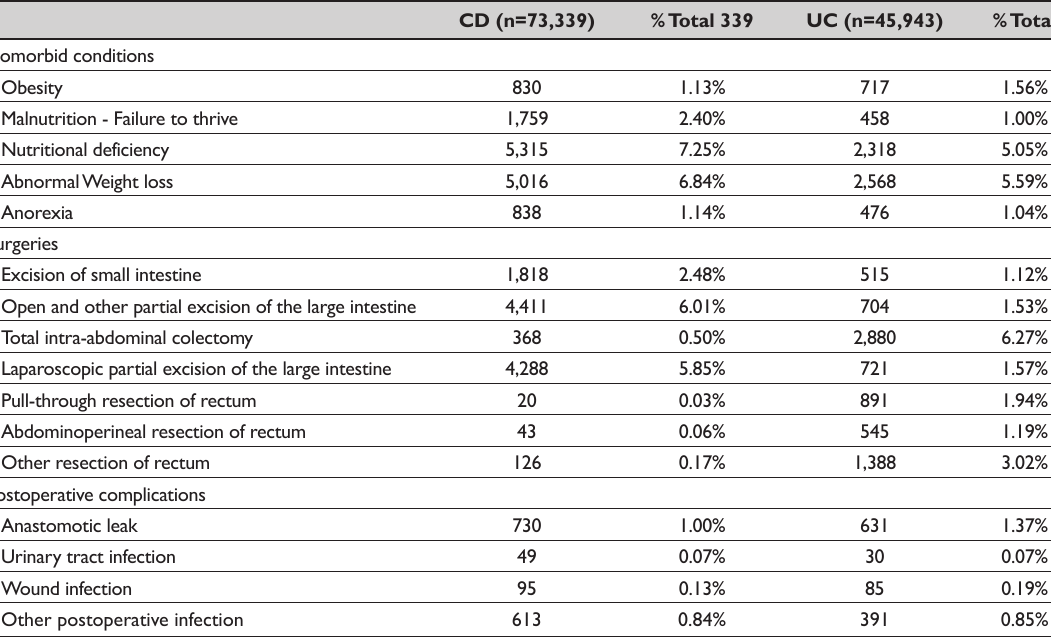
Table 2: Comorbidities, procedures and postoperative complications for Crohn’s disease (CD) and ulcerative colitis (UC) hospitalizations – all years combined